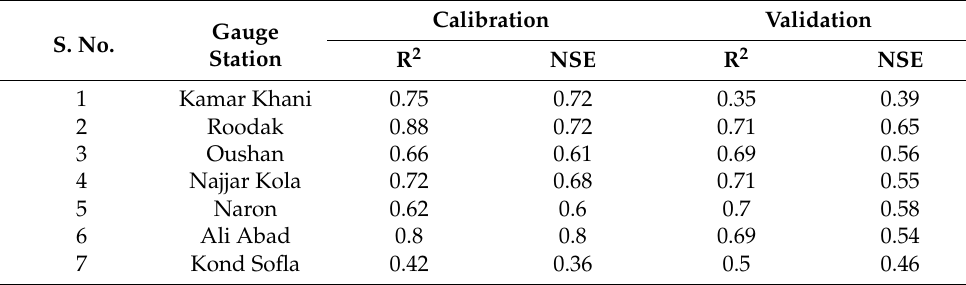
Table 4. Calibration and validation results of all seven stations for streamflow.